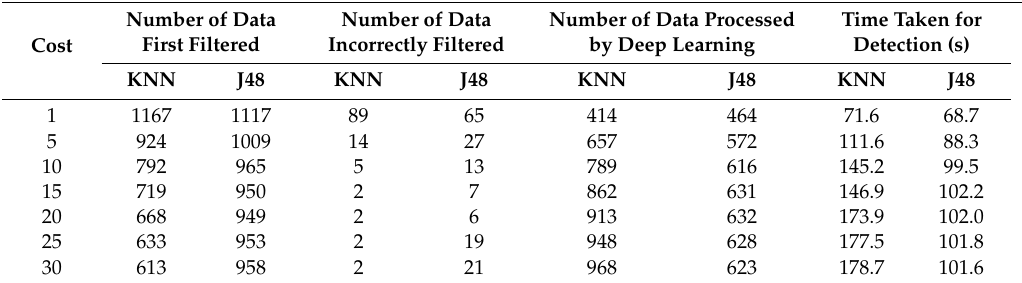
Table 5. Filtering result according to cost